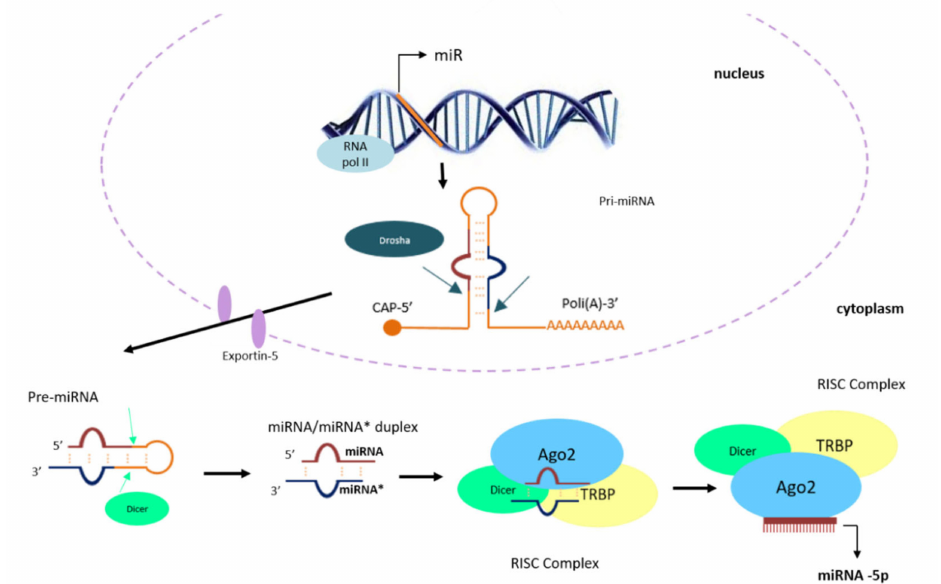
Figure 1. Biogenesis of microRNAs. Within the nucleus, RNA polymerase II synthesizes a long primary miRNA (pri- miRNA), from intronic, exonic or intragenic sequence. Pri-miRNA is characterized by a hairpin structure due to the pairing of inverted and close repetition. The microprocessor complex, consisting of Drosha (nuclear RNAse III) and Di George syndrome chromosomal region 8 (DGCR8), cleaves the pri-miRNA to form a precursor miRNA, a double helix called pre-miRNA. The pre-miRNA is exported to the cytoplasm in an Exportin-5/RanGTP-dependent manner. Dicer processes pre-miRNA into the cytoplasm by removing the terminal loop that forms the hairpin, giving rise to a miRNA/miRNA duplex *, consisting of a guide and passenger strand (indicated with an asterisk). Both strands originated from this miRNA maturation process are loaded onto ARGONAUTA2 (AGO2) protein in an ATP-dependent manner, to form an effector complex called RNA-Induced Silencing Complex (RISC). The RISC Complex is formed by the miRNA/miRNA * duplex loaded to the AGO2 protein, but also by Dicer and the TAR RNA-binding protein (TRBP) protein, which contribute to the formation of the mature RISC complex. In the formation of the effective, mature RISC complex, AGO2 unwinds and cleaves the passenger strand, giving rise to a mature single-stranded miRNA, which will perform the regulatory function. Two mature miRNAs could be originated from the pri-miRNA; one from the 5 (cid:48) arm and one from the 3’ arm of the hairpin thus they take the suffix -5 (cid:48) or -3 (cid:48)